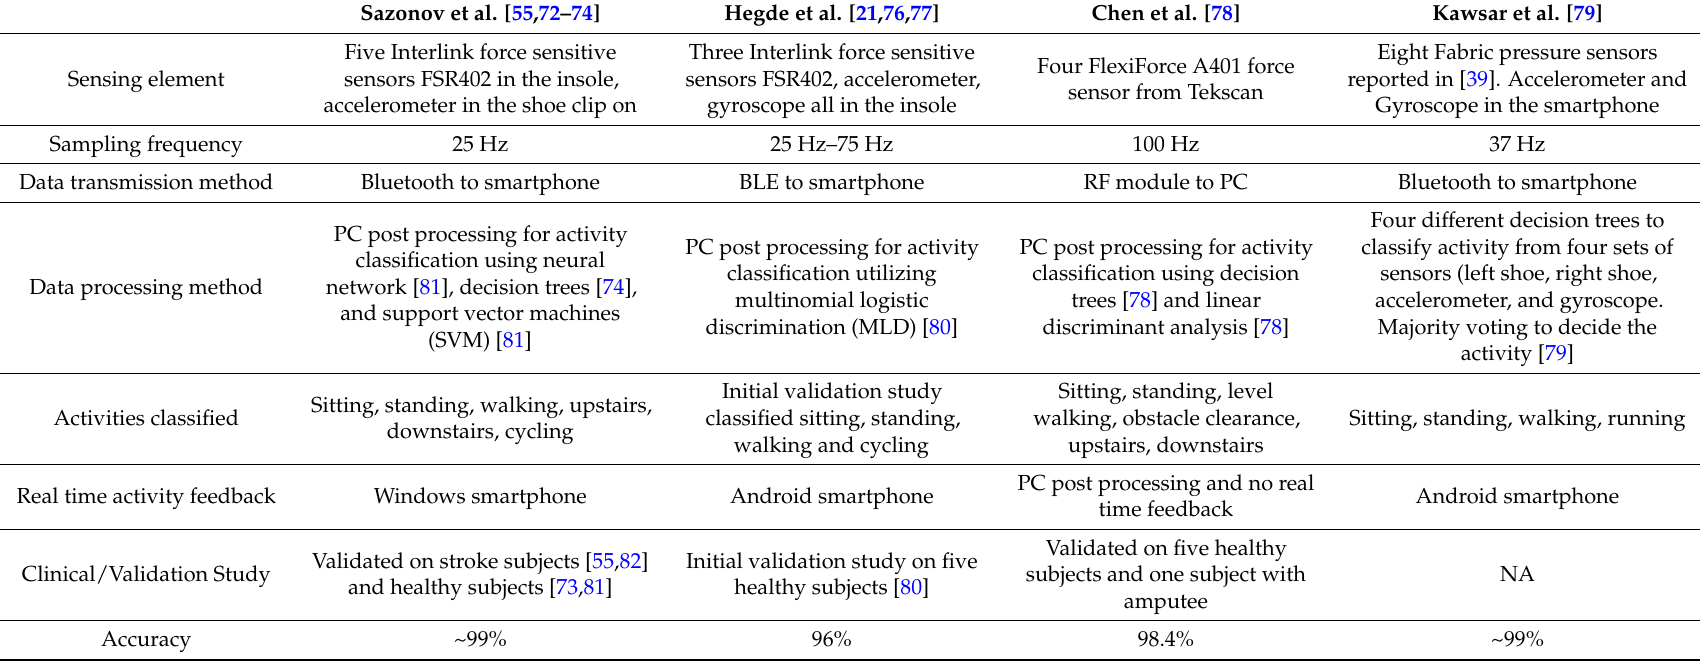
Table 3. Comparison of footwear-based posture and activity recognition